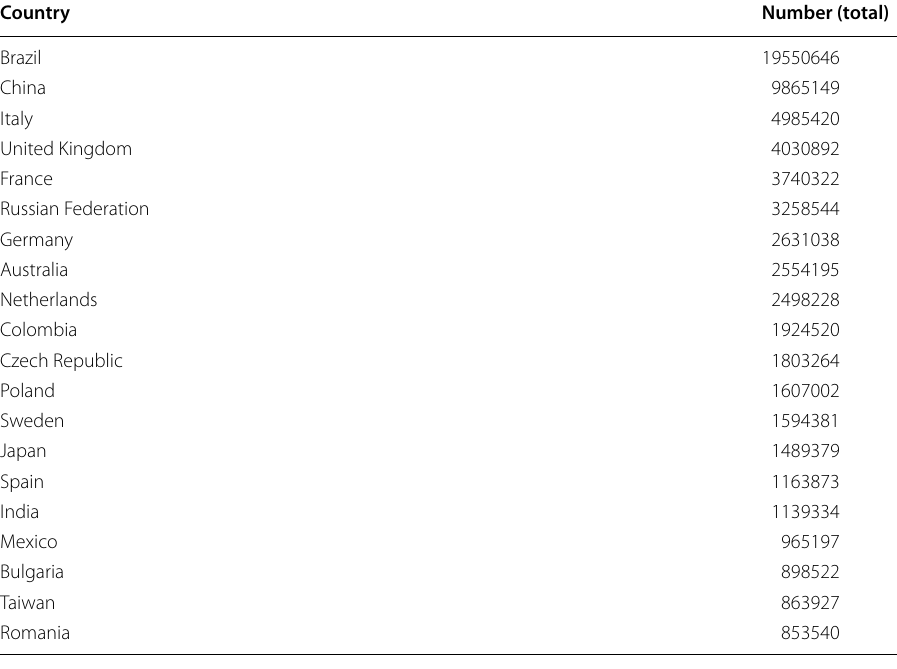
Table 2 Top 20 most frequent countries in total Country